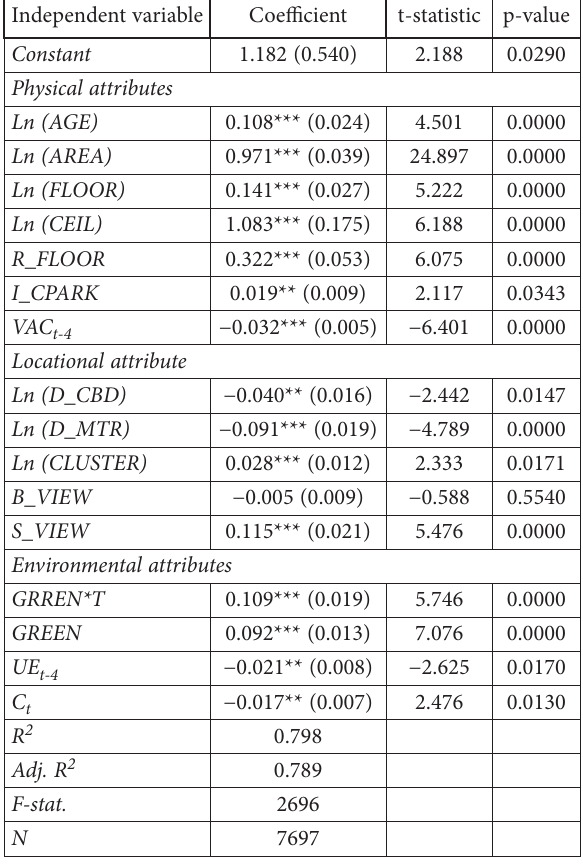
Table 6. Results for the